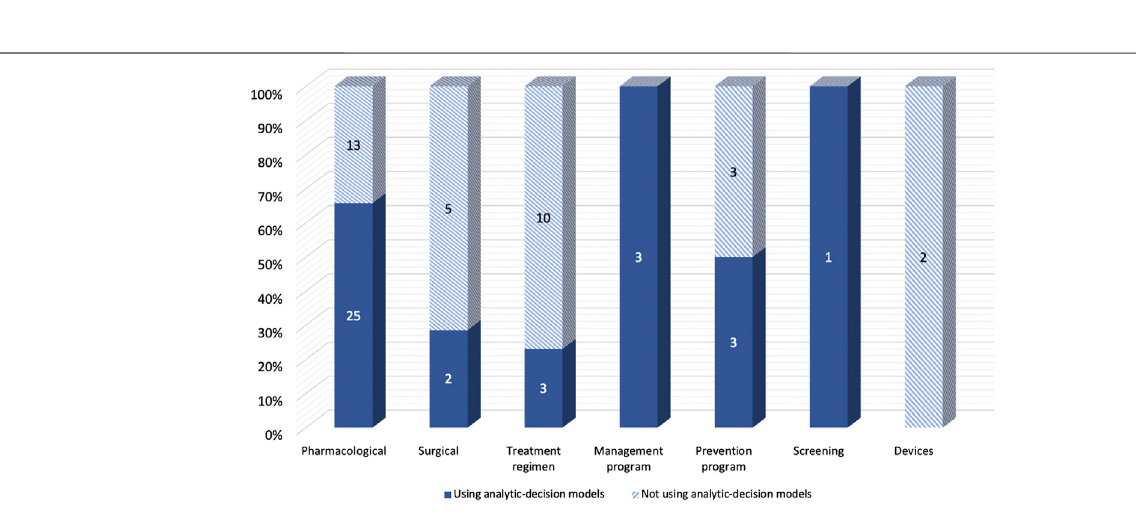
FIGURE 4 | Differences in intervention categories between real-world cost-effectiveness analysis with or without decision-analytic model.